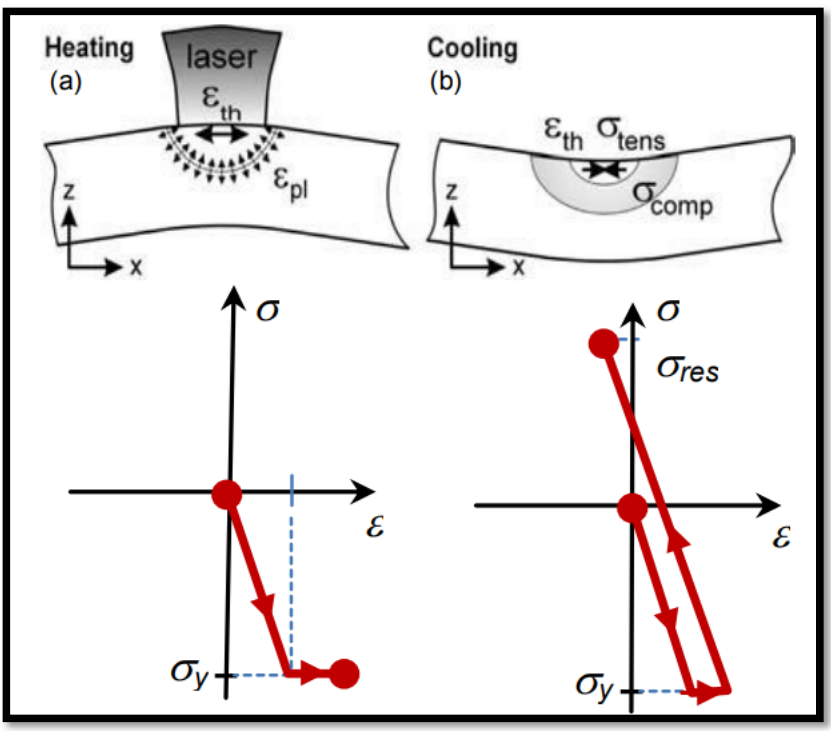
Figure 21. Residual stress generation ( a ) Heating, ( b ) Cooling [72].